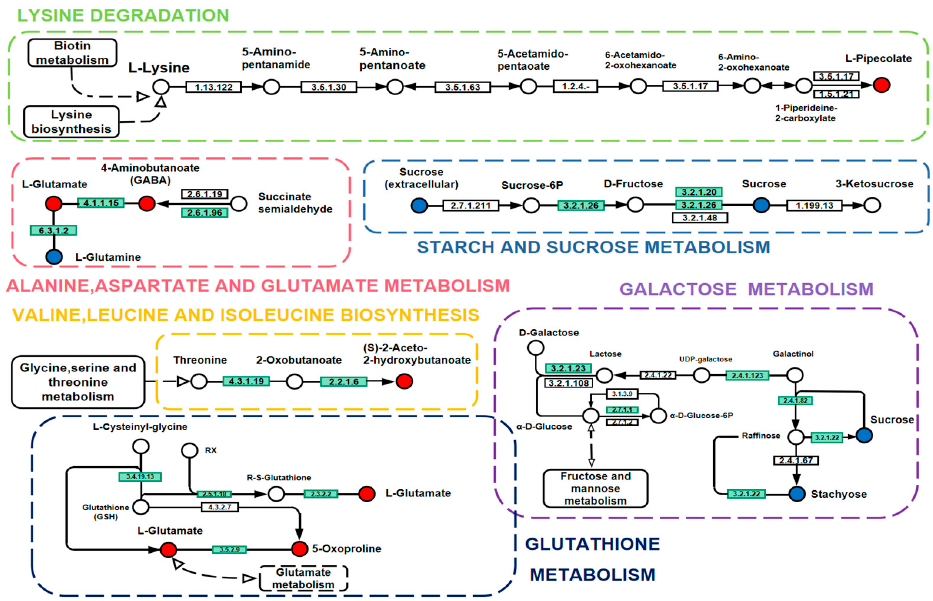
Figure 7. The key differential metabolites of HT_6 vs. CK groups and HT_6 vs. LT_6 groups were mapped to metabolic pathways, and the results of metabolic pathway analysis are shown in the KEGG pathway results.